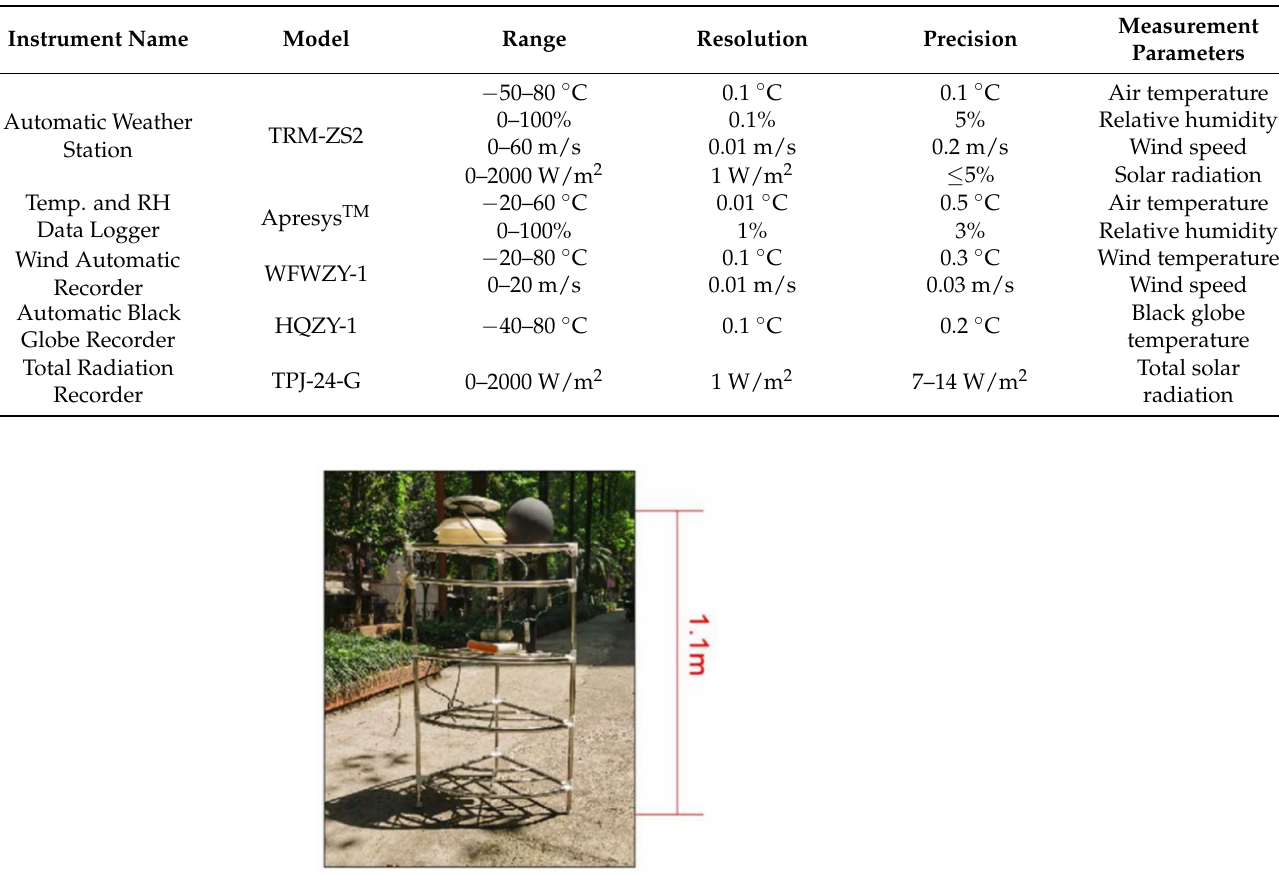
Table 1. Main parameters of the measuring instruments.